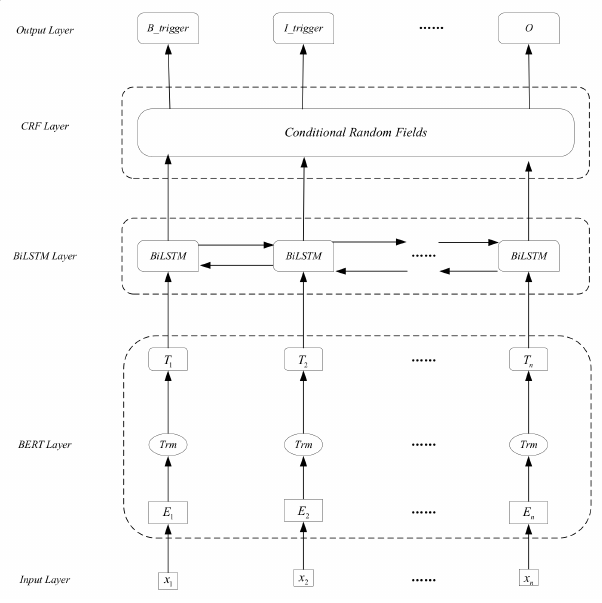
Figure 3. Structure of triggers recognition model.